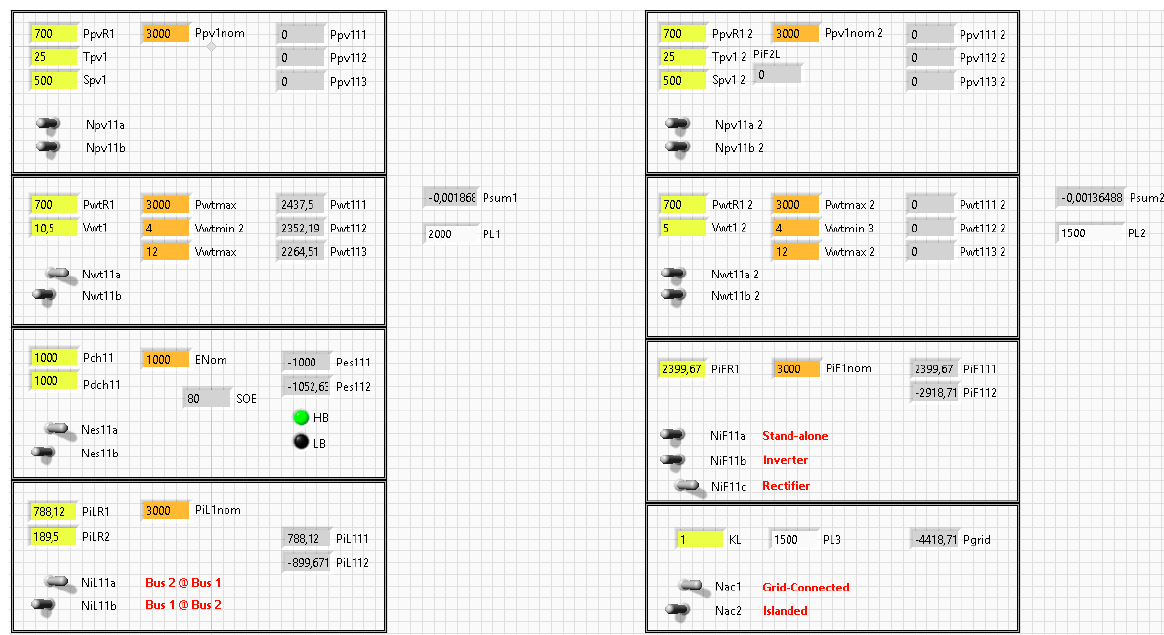
Figure 17. LabVIEW programming for the AC bus.